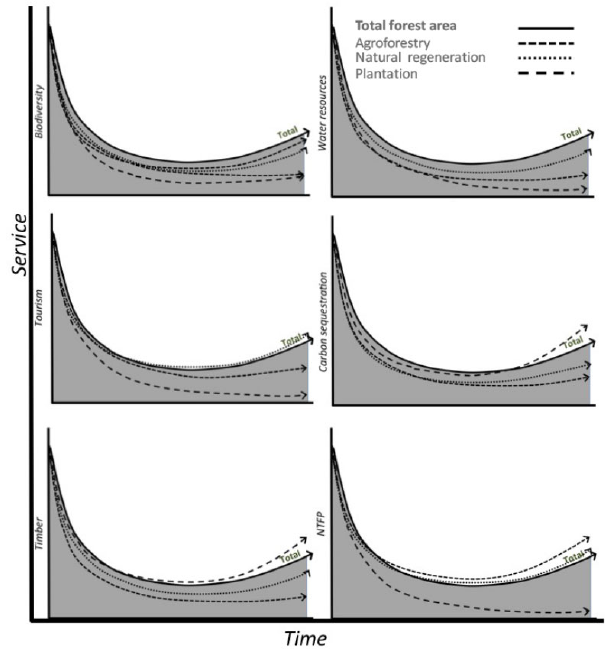
Fig. 4 . Forest ecosystem-service transition curves. The total forest cover depicted in a classic forest-transition curve is indicated by a solid line. Each panel shows conceptual curves of how quickly a given service recovers relative to forest area for each type of forest transition. (NTFP: nontimber forest